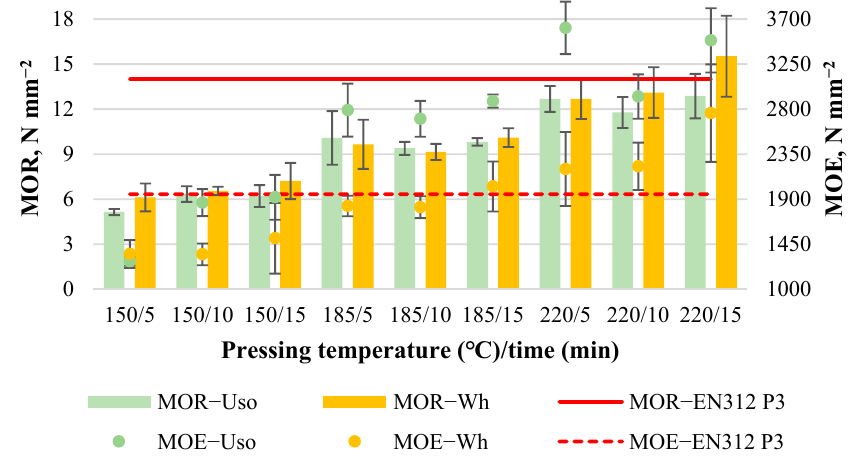
Figure 3. Bending properties of binder-less boards with a density of 800 kg m − 3 depending on the crop and pressing variables.